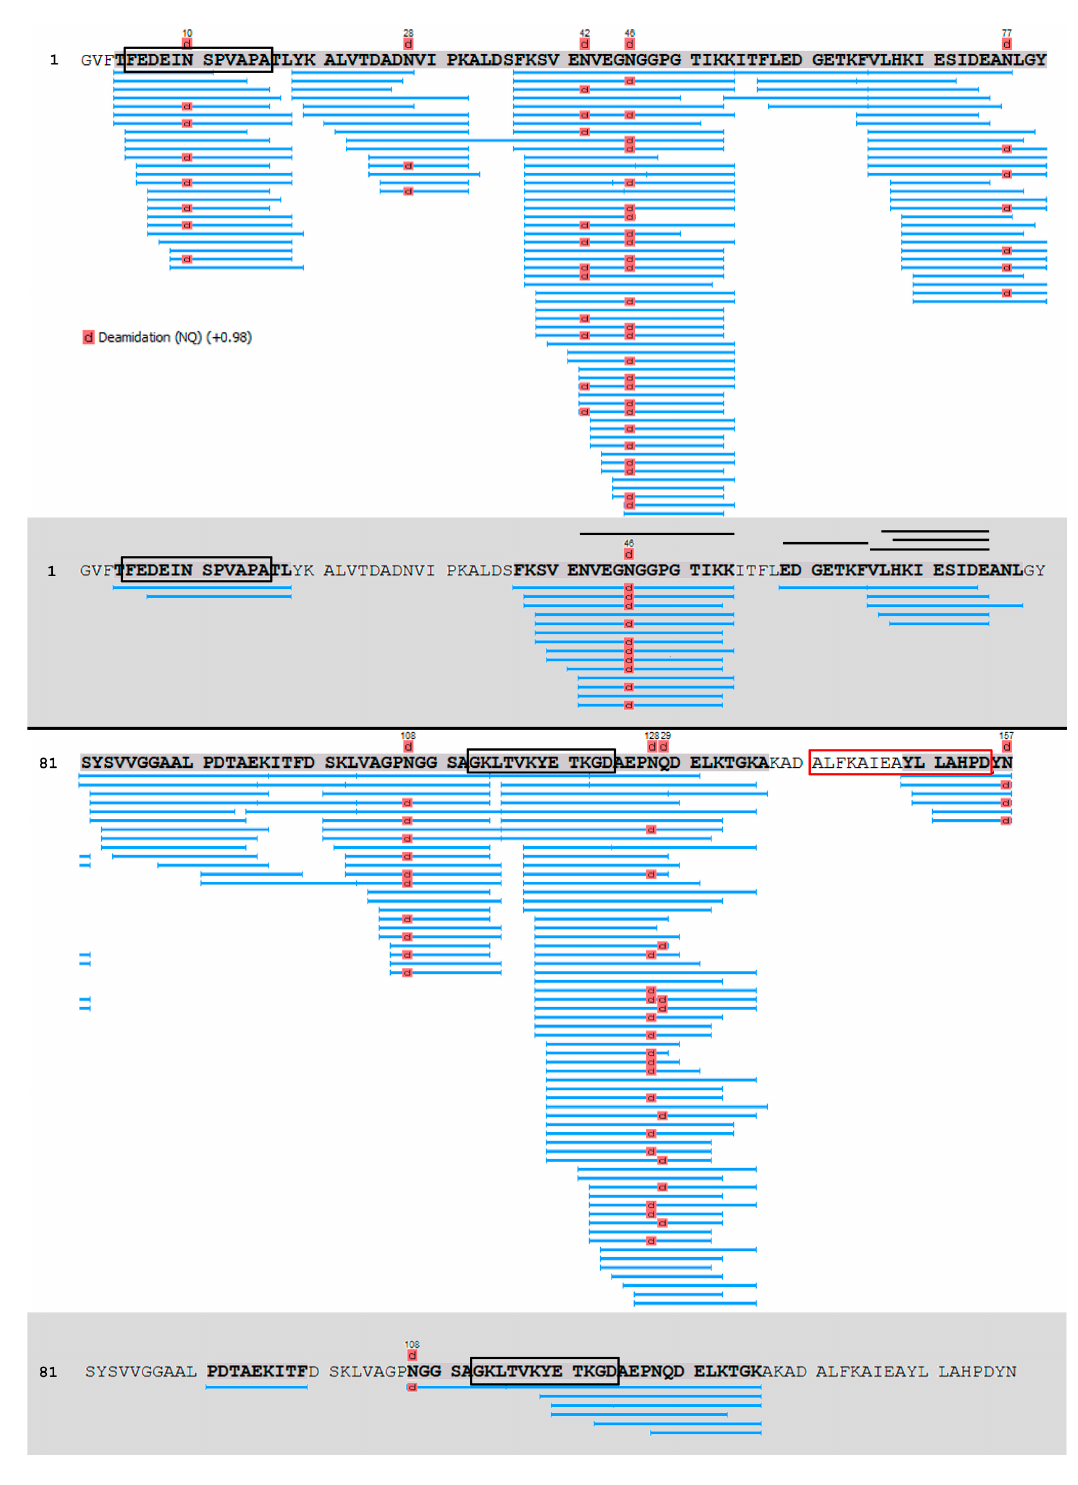
Figure 4. The fragments of Gly m 4 resulted from proteolysis mimicking gastrointestinal digestion in vitro (white background), and those ones crossed the Caco ‐ 2 epithelial barrier (grey background). Amino acid regions highlighted in bold are denoted sequence, covered by identified LC ‐ MS/MS fragments. Regions, homologous to T ‐ cell epitopes of Bet v 1 able to induce proliferation of Bet v 1 ‐ specific T ‐ cell lines from more than 10 patients out of 57 ones, are framed in black, and the immunodominant T ‐ cell epitope of Bet v 1 is framed in red [28]. The most abundant proteolytic fragments of Gly m 4 identified in basolateral chambers are marked with black lines above its sequences.